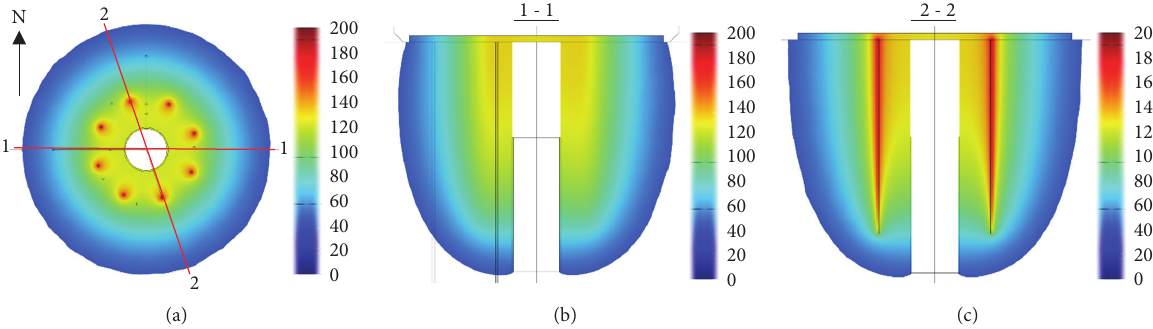
Figure 16: Temperature [ ∘ C] distribution after 9 weeks of heating shown in (a) top view, (b) cross section plane, and (c) in HH4-HH8 plane.